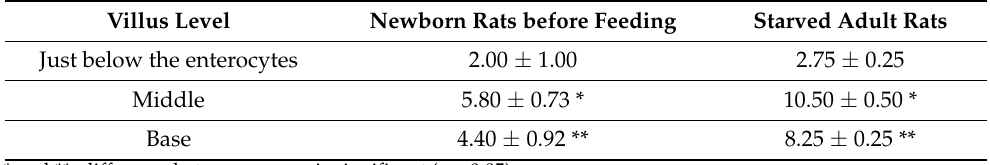
Table 3. Area of lymphatic capillary profiles on cross-sections of intestinal villi of white rats (in µ m 2 ). Newborn Rats Newborn Rats after Villus Level Starved Adult Rats before Feeding Feeding Just below the